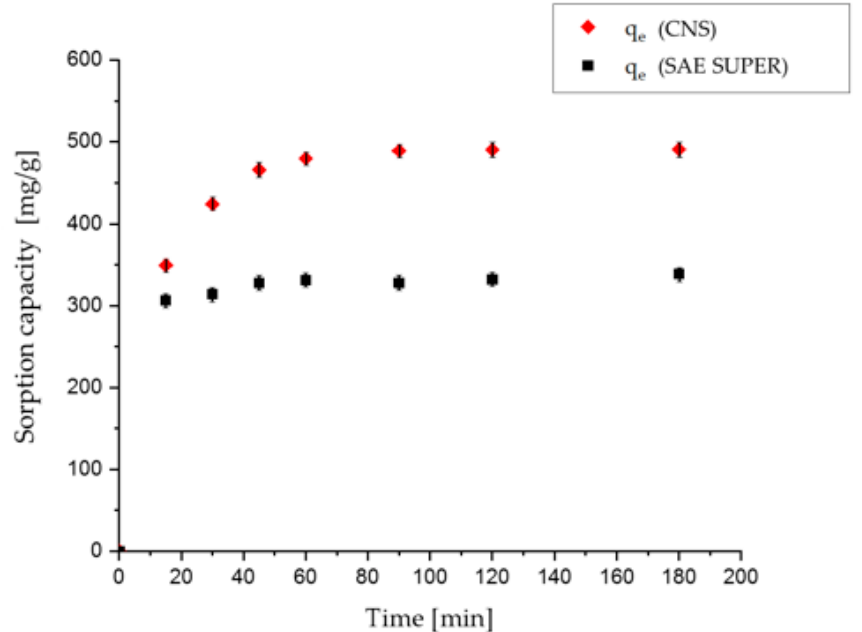
Figure 9. Comparison between SAE-activated carbon and sponge sorption kinetics for OSS dye at 800 mg/L concentration.